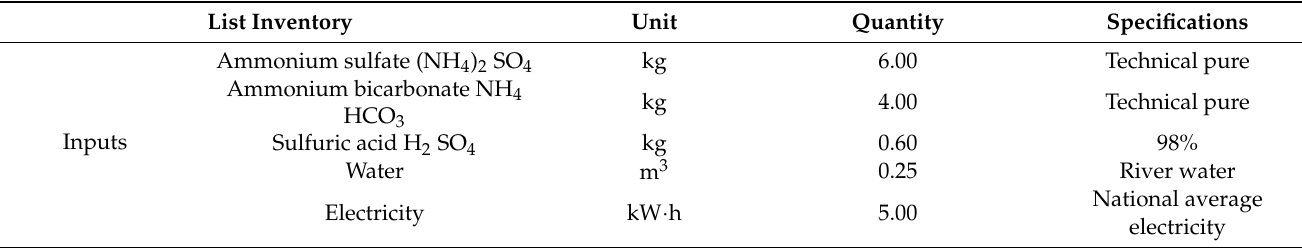
Table 1. Life cycle inventory data of ammonium leaching